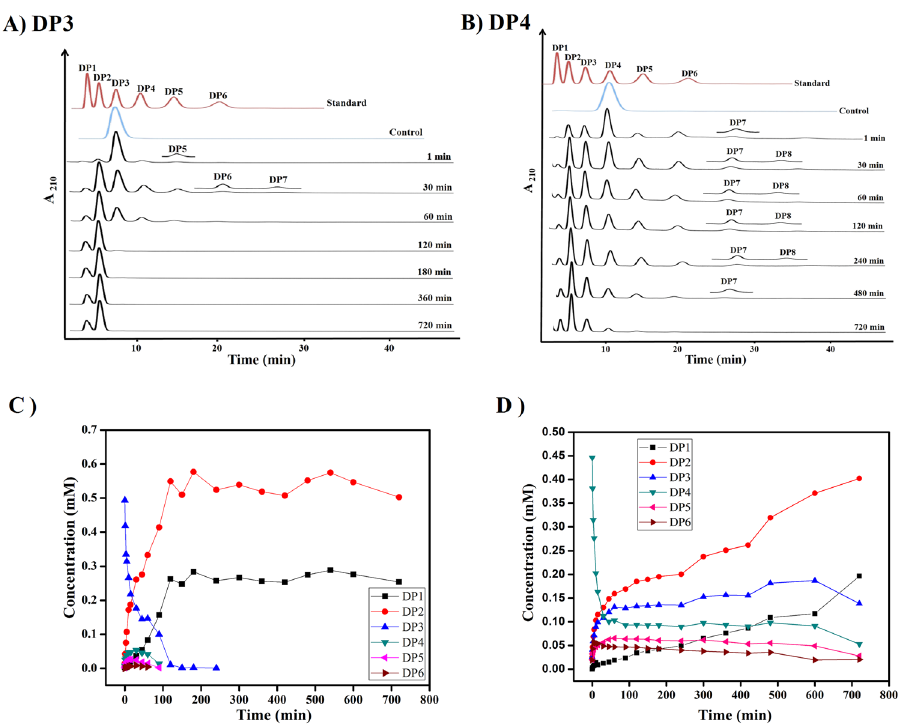
Figure 4. Time course hydrolysis and TG catalyzed by Ec Chi1 with DP3, DP4. The reaction mixture was incubated with 200 nM of Ec Chi1 and 1 mM of DP3/DP4 for different time periods from 0 to 720 min at 40 °C. Products were analyzed by binary gradient HPLC. ( A and B ) HPLC profiles of reaction products from DP3 ( A ) and DP4 ( B ) substrates. The topmost profile shows a standard mixture of CHOS ranging from DP1 to DP6 ( A and B ). The other profiles show the reaction products from DP3 and DP4 substrates at the indicated incubation times. The inset shows a magnified view of the low-peak-area products. Control represents the substrate without Ec Chi1. Overview of concentrations of CHOS products generated during reaction time courses with DP3 ( C ) and DP4 ( D ) substrates. Products were quantified from respective peak areas using standard calibration curves of CHOS ranging from DP1 to